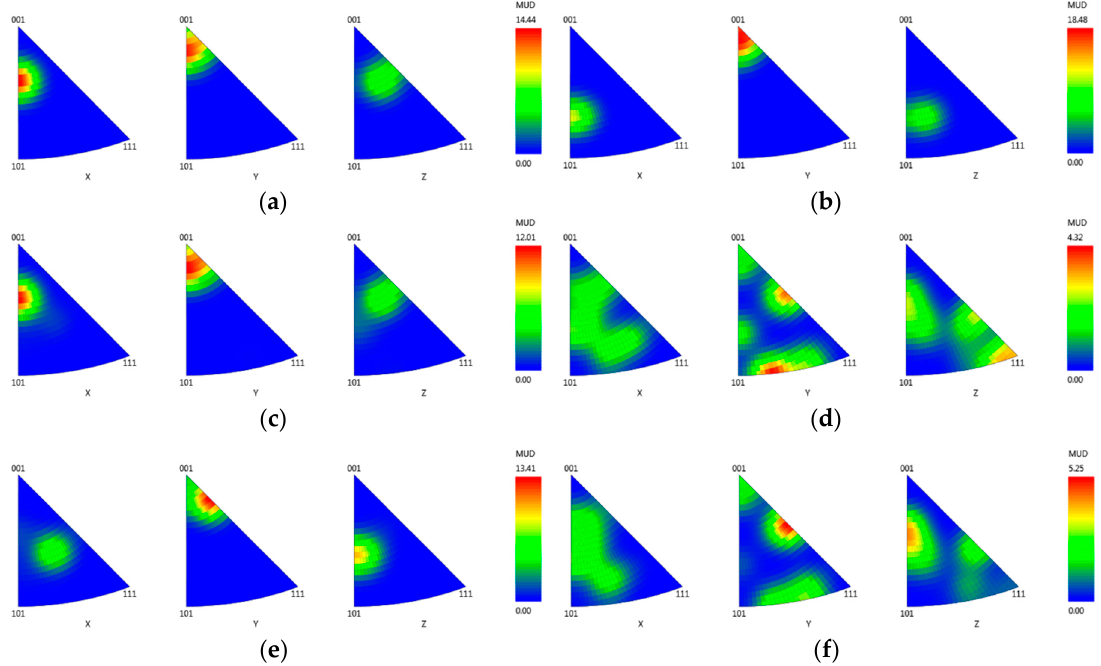
Figure 8. Inverse pole figures of: ( a , b ) Ni; ( c , d ) TaC; ( e , f ) TiC in LC-SC samples of CMSX-6 + 0.03C directionally solidified at 0.13 K · s − 1 ( a , c , e ) and 0.4 K · s − 1 ( b , d , f ).